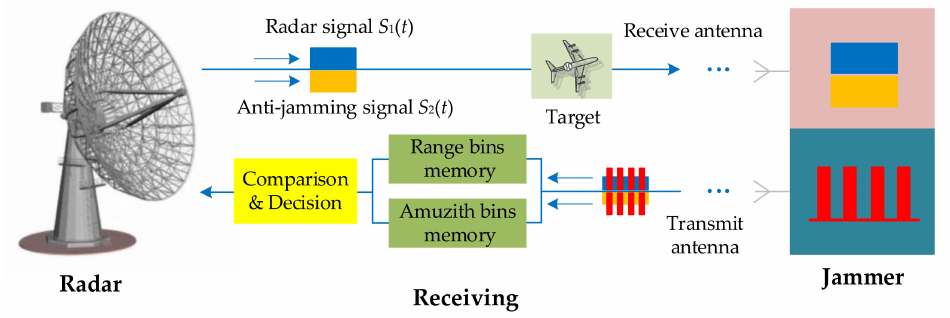
Figure 5. Jamming flowchart.